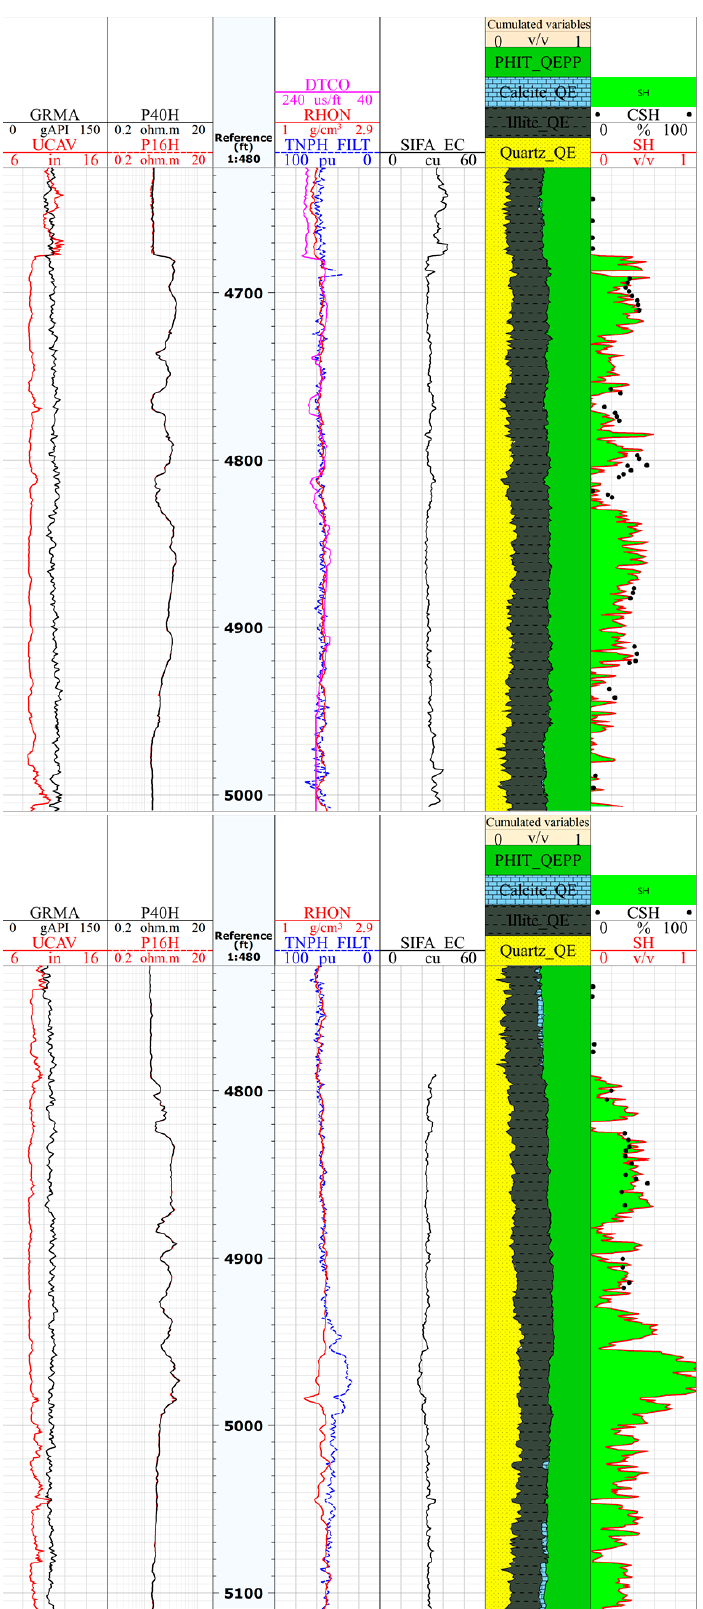
Figure 6. Sigma logging saturation model and core data in Wells W1 and W2.